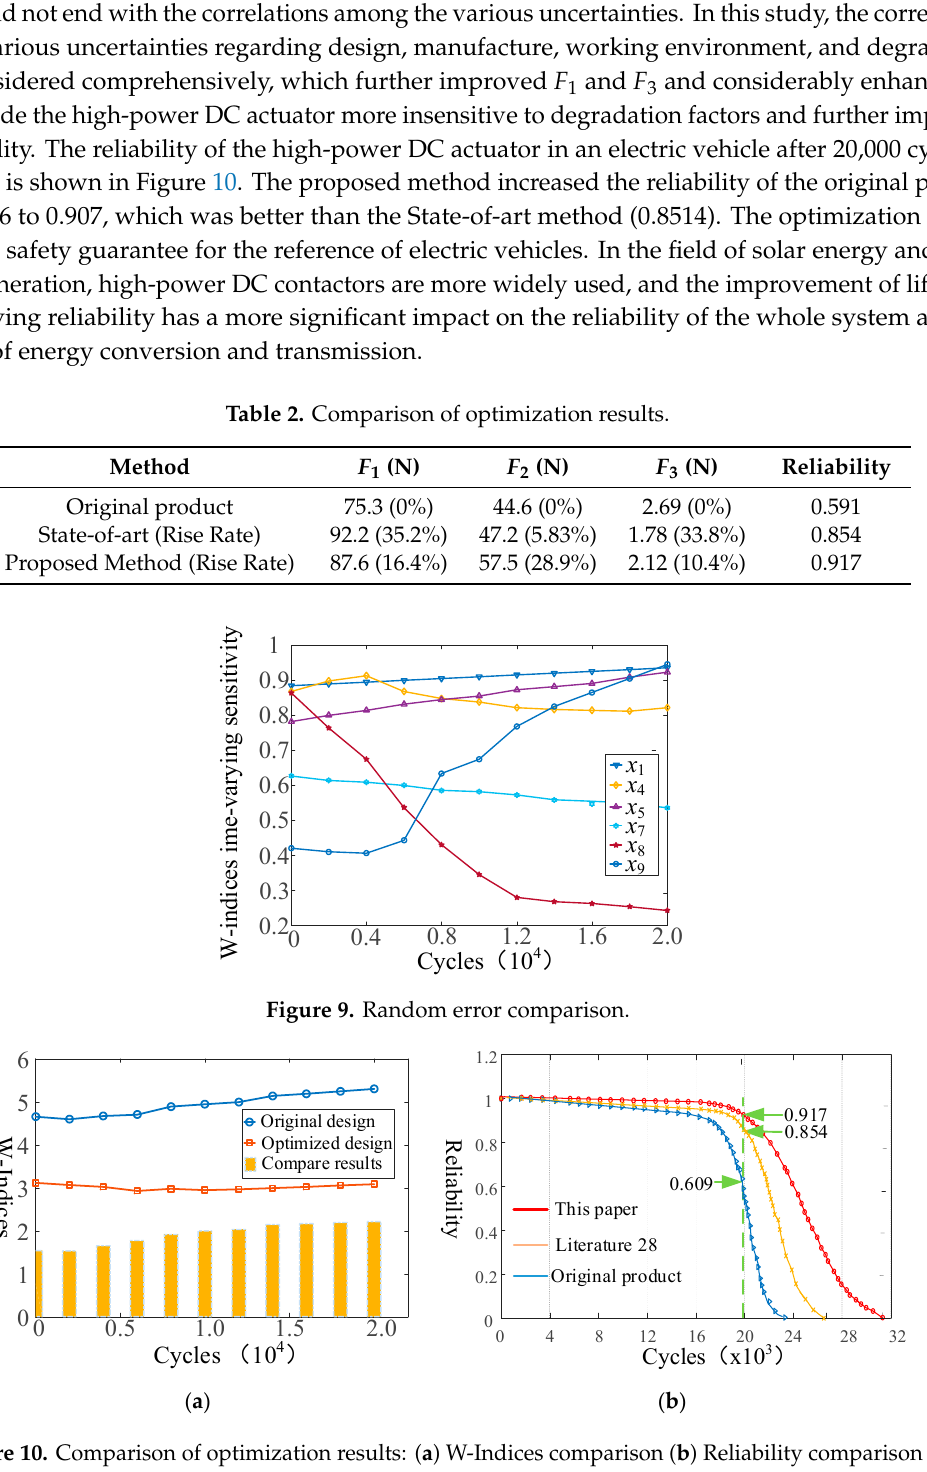
Table 2. Comparison of optimization results. Method